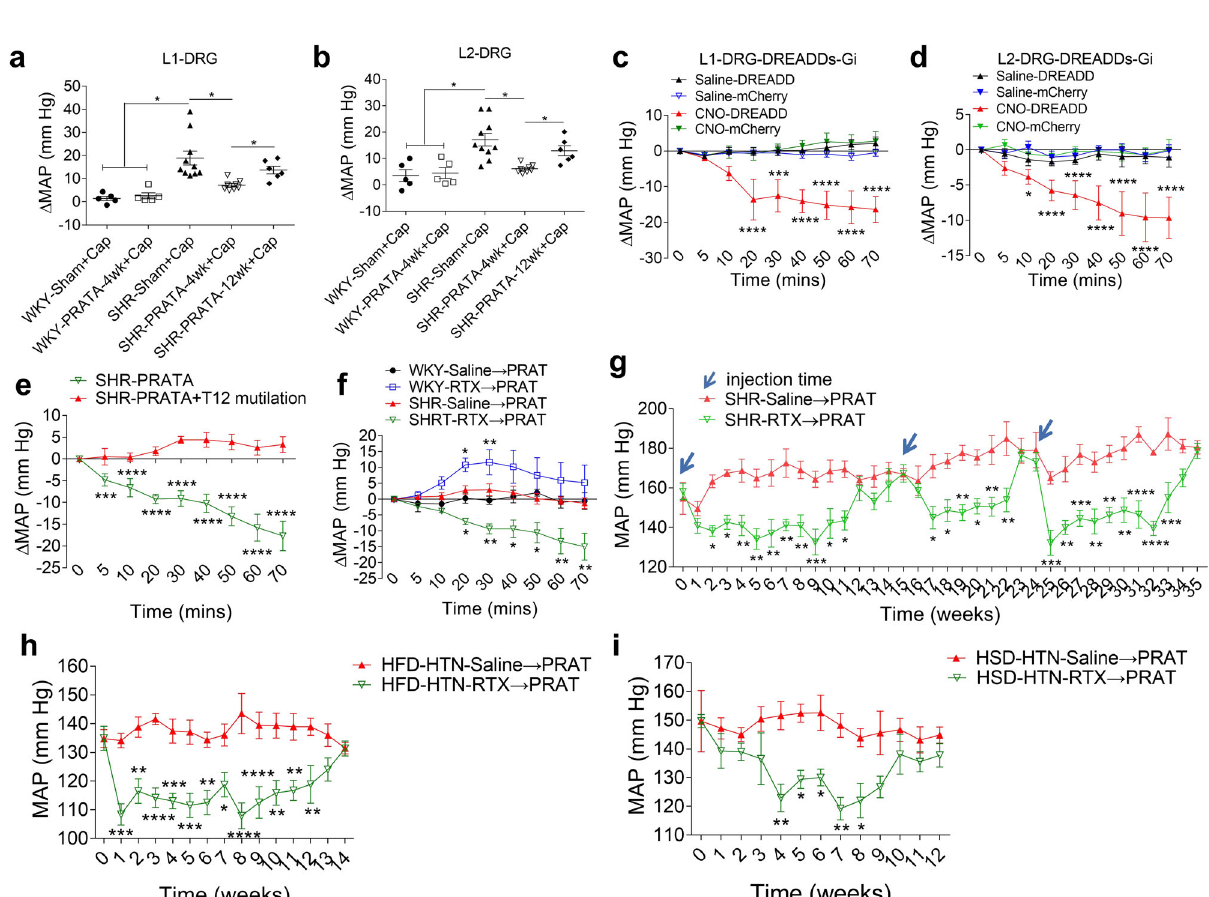
Fig. 3 Enhanced L1-L2 DRG neuron activity as a regulator for high BP. a , b Changes of intracarotid arterial MAP under L1-L2 DRG injection with capsaicin post PRATA, n = 5 for WKY-Sham + Cap and WKY-PRATA-4wk + Cap groups, n = 10 for SHR-Sham + Cap group, n = 8 for SHR-PRATA-4wk + Cap group, n = 6 for SHR-PRATA-12wk + Cap group; Data are mean ± SEM. * P < 0.05. ANOVA, Bonferroni post-hoc test, two-sided. c , d Changes of the intracarotid arterial MAP after selective inhibition of neuronal activity of L1-L2 DRGs using Gi-DREADDs in SHR, n = 5 for Saline-DREADD and CNO- DREADD group, n = 6 for Saline-mCherry and CNO-mCherry group; Data are mean ± SEM. * P < 0.05, *** P < 0.001, **** P < 0.0001 compared with Saline- DREADD group. ANOVA, Bonferroni post-hoc test, two-sided. e Changes of the intracarotid arterial MAP post PRATA with or without T12 spinal cord mutilation, n = 6 for SHR-PRATA group, n = 5 for SHR-PRATA + T12 mutilation group; Data are mean ± SEM. *** P < 0.001, **** P < 0.0001. ANOVA, Bonferroni post-hoc test, two-sided. f Changes of the intracarotid arterial MAP post PRAT denervation by RTX in SHRs, n = 6 per group; Data are mean ± SEM. * P < 0.05, ** P < 0.01. ANOVA, Bonferroni post-hoc test, two-sided. g Weekly measurement of tail arterial BP post three repeated PRATD by RTX in SHRs, n = 6 per group; Data are mean ± SEM. * P < 0.05, ** P < 0.01, *** P < 0.001, **** P < 0.0001. ANOVA, Bonferroni post-hoc test, two-sided. h , i Weekly measurement of tail arterial BP post PRATD in HFD induced hypertensive rats ( h ) and HSD induced hypertensive rats ( i ), n = 8 for HFD-HTN- Saline → PRAT group, n = 7 for HFD-HTN-RTX → PRAT group in ( h ); n = 7 per group in ( i ); Data are mean ± SEM. * P < 0.05, ** P < 0.01, *** P < 0.001, **** P < 0.0001. ANOVA, Bonferroni post-hoc test, two-sided. Saline → PRAT: injection of saline into perirenal adipose tissue, RTX → PRAT: injection of resiniferatoxin into perirenal adipose